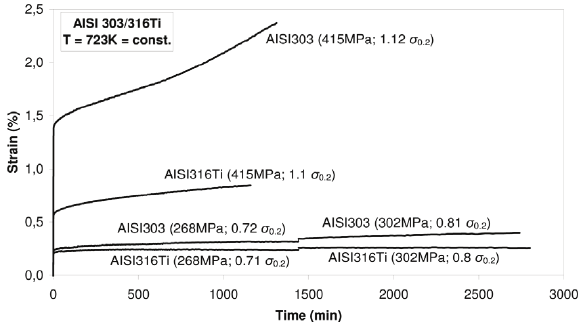
Figure 4. Creep behavior of AISI 303 steel and AISI 316Ti steel at temperature of T D 723 K.